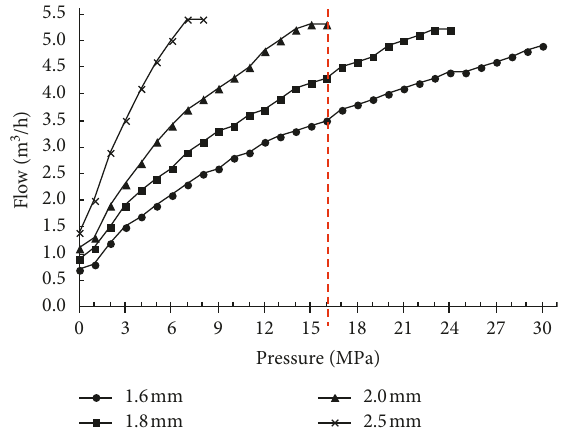
Figure 12: The pressure-flow test results of different jet nozzles in